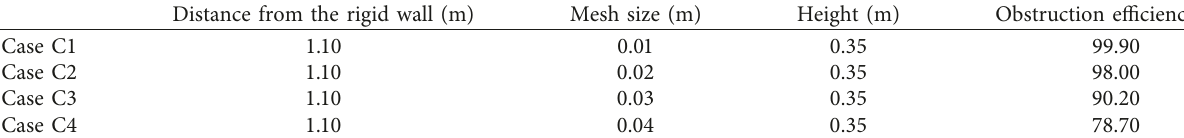
Table 4: Obstruction efficiency of the RNB with different mesh sizes.